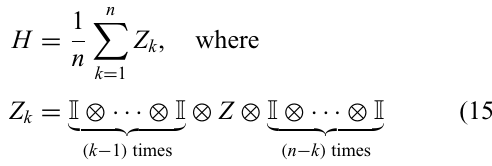
figuration: (cid:3) U | ψ (cid:9)(cid:10) ψ | U † − V | ψ (cid:9)(cid:10) ψ | V † (cid:3) | ψ (cid:9)(cid:10) ψ |(cid:3) = 1. 1